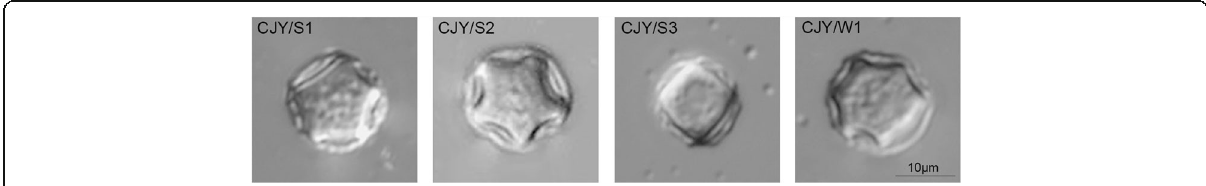
Fig. 1 Photomicrographs of cysts of the Acanthamoeba isolates CJY/S1, CJY/S2, CJY/S3, and CJY/W1. Images were taken under a bright-field inverted microscope. Bar =10 μ m